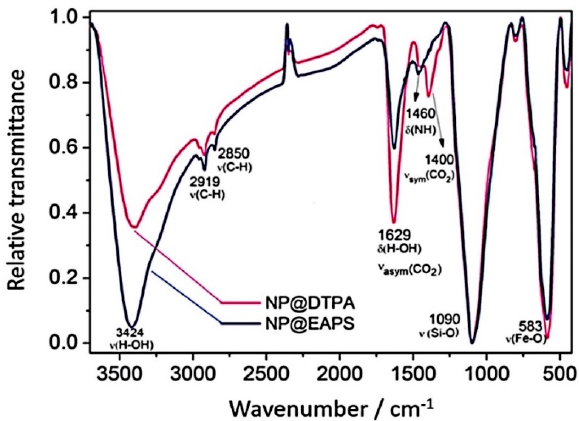
Figure 4. Typical FTIR spectra of the ( — ) Fe 3 O 4 @SiO 2 / EAPS and ( — ) Fe 3 O 4 @SiO 2 / EAPS / DTPA nanoparticles (adapted with permission from [29]).